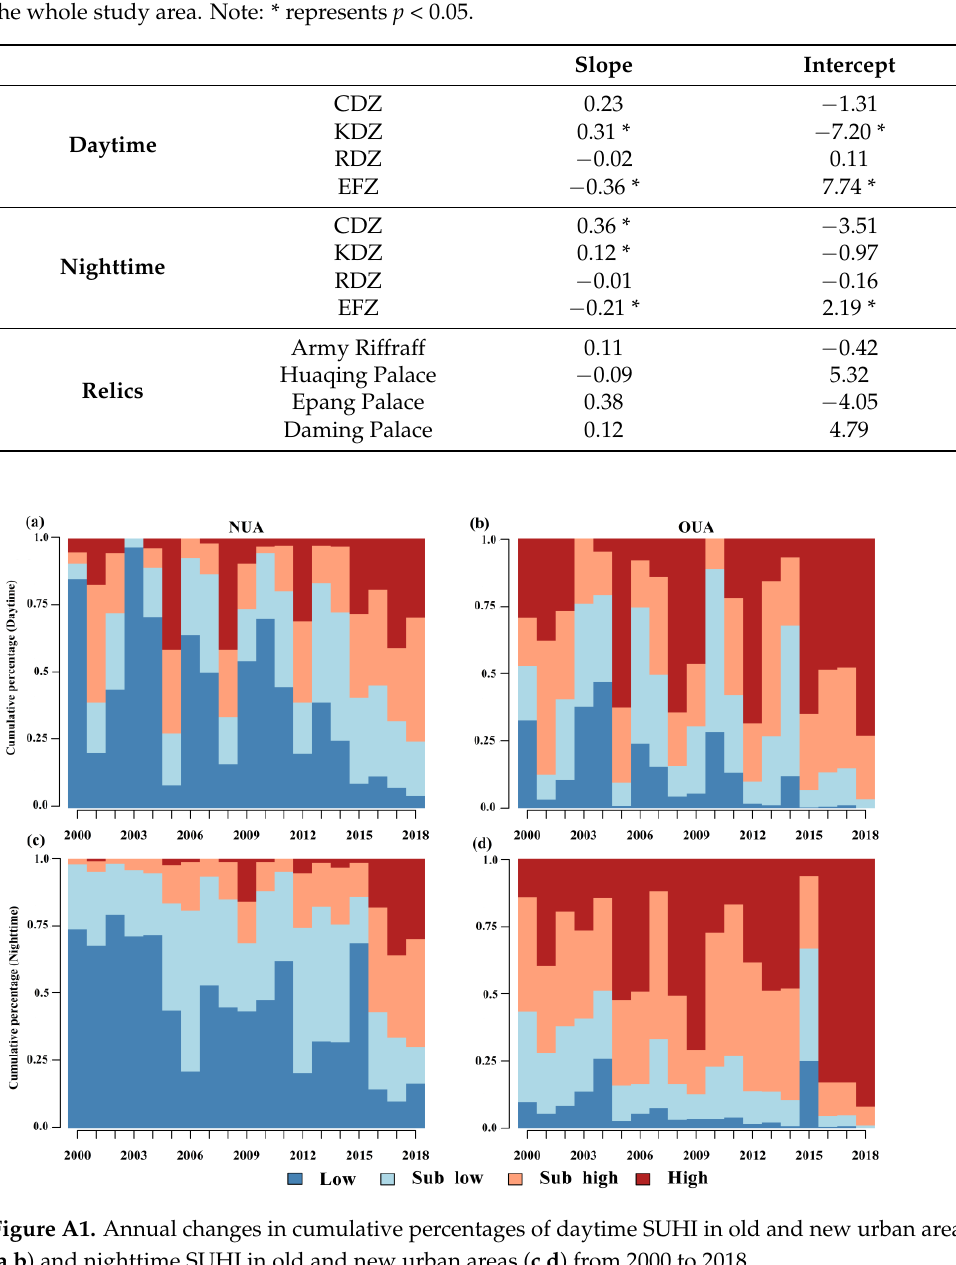
Table A1. Slope and intercept values of the fitting lines of LST differences and mean LST values of the whole study area. Note: * represents p < 0.05.